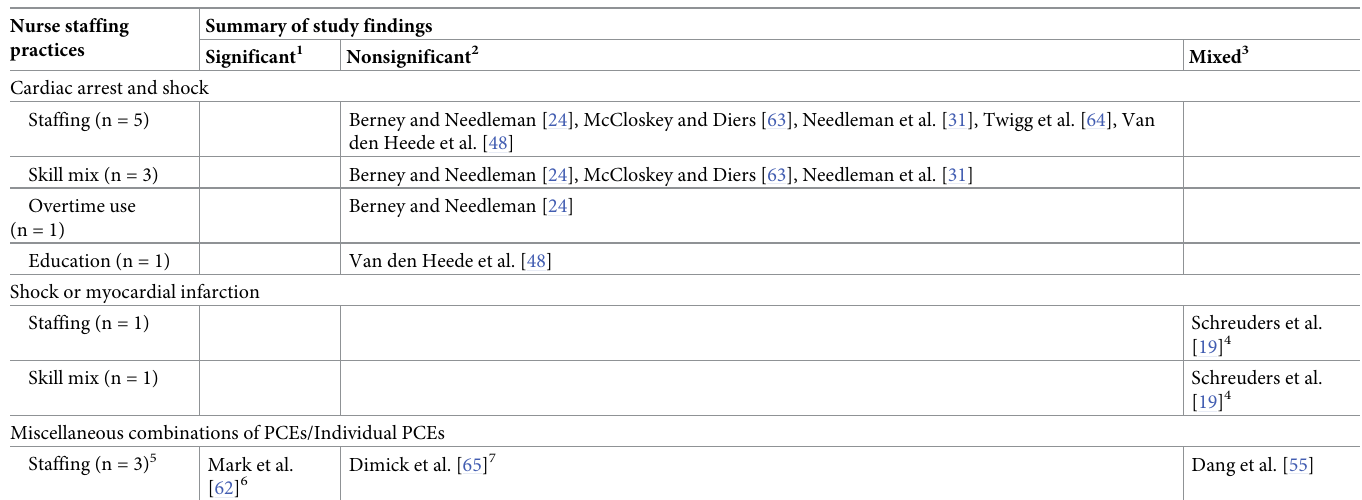
Table 2. Nurse staffing practices in association with Postoperative Cardiac Events